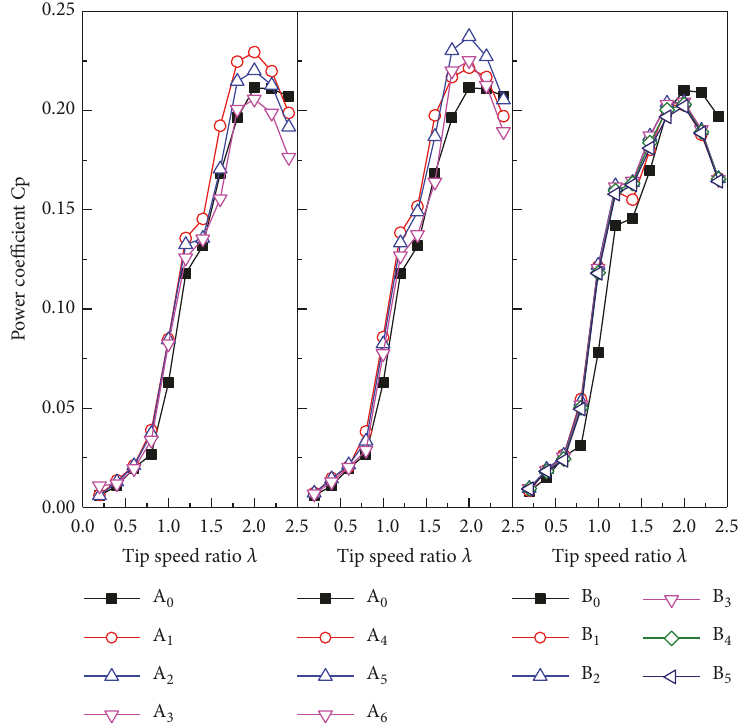
Figure 6: Power coefficients for different working conditions.